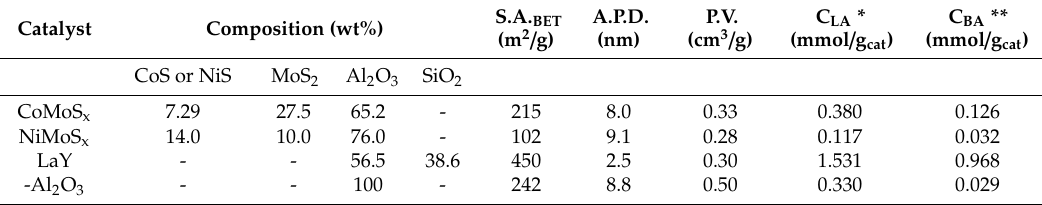
Table 1. Chemical-physical properties and acid sites quantification of catalysts.